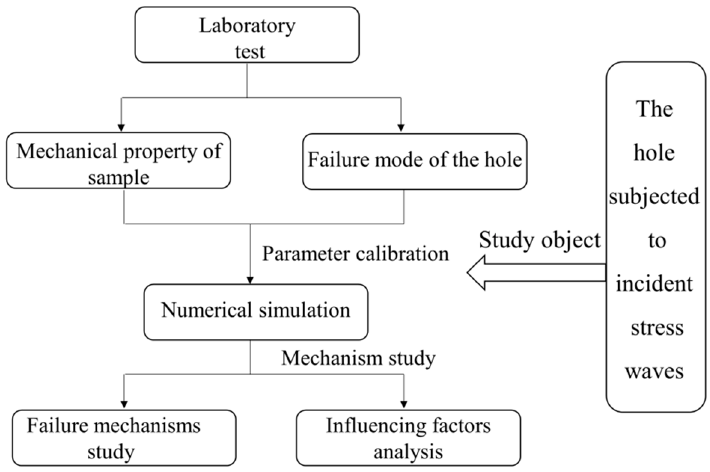
Figure 1. The flowchart of the study.